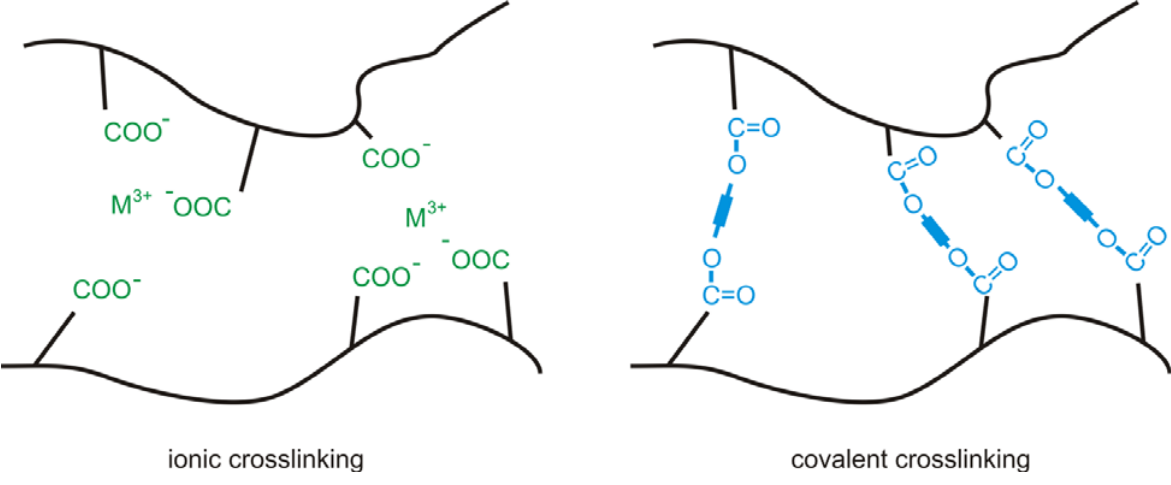
Figure 5. Possible crosslinking methods in polymers containing carboxyl groups. In ionic crosslinked polymers the metal ions form a complex with several deprotonated carboxyl groups. Covalent crosslinking can be achieved thermally or